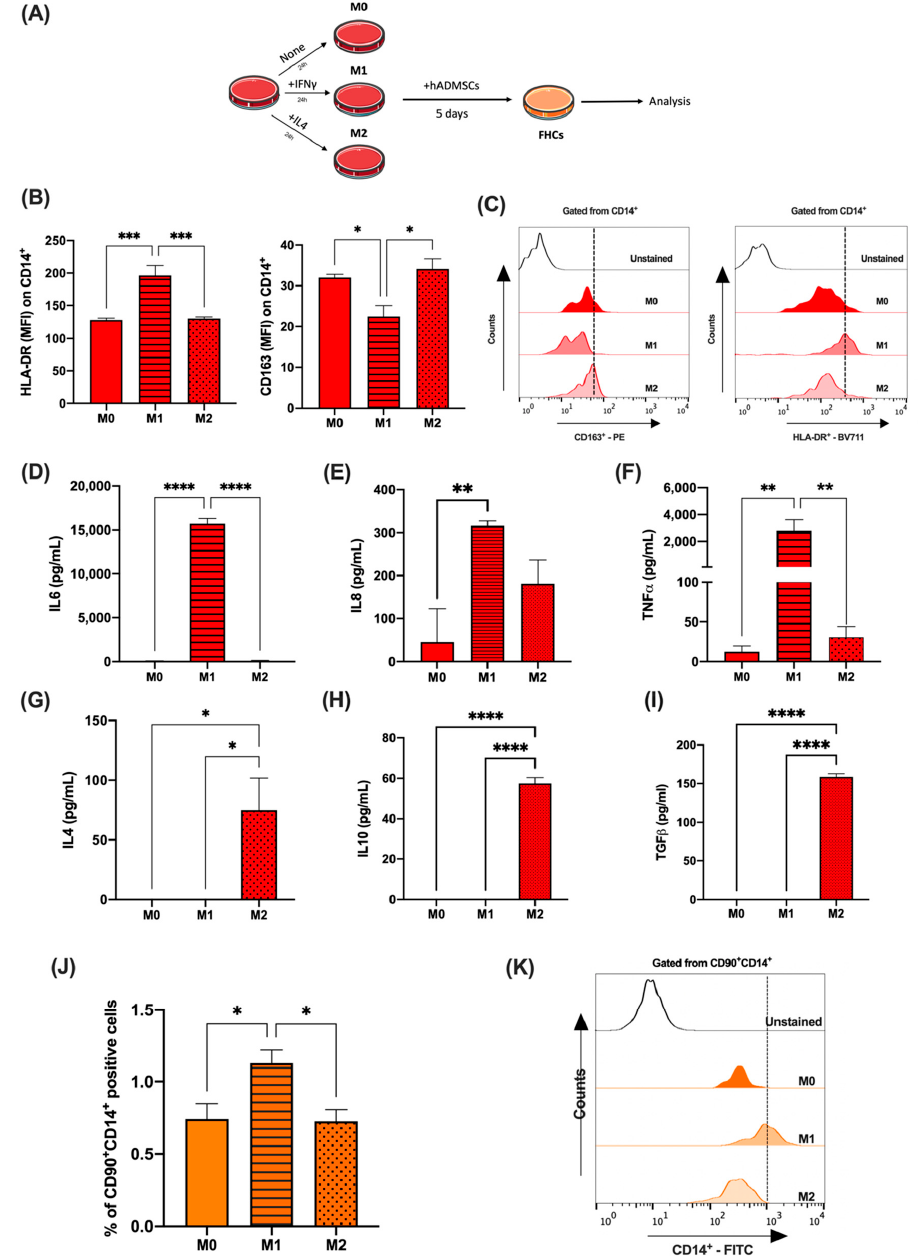
Figure 2. Human monocyte polarisation to M1 yields a greater number of FHCs. ( A ), Schematic representation of experimental monocyte polarisation and co-culture conditions. ( B ), Mean fluorescence intensity (MFI) of surface markers CD163 and HLA-DR on control, M1 (dashed bar) and M2 (dotted bar) polarised monocytes (n = 4). ( C ), Representative FACS histograms of CD163 and HLA-DR fluorescence intensity gated from CD14 + Unstained (clear) M0 (dark red) M1 (red) and M2 (light red) human monocytes are shown. Cytokine levels of ( D ), IL6; ( E ), IL8; ( F ), TNF α ; ( G ), IL4; ( H ), IL10 and ( I ), TGF β in cell supernatants from control, M1 (dashed bar) and M2 (dotted bar) polarised monocytes (n = 4). ( J ), Percentages of CD90 + CD14 + cells of hADMSCs cocultures with M0, M1 (dashed bar) and M2 (dotted bar) polarised monocytes (n = 4). ( K ), Representative FACS histograms of CD14 expression in gated CD90 + C14 + cells from hADMSCs cocultures with M0, M1 and M2 monocytes. *, p < 0.05; **, p < 0.01; ***, p < 0.001; ****, p < 0.0001 in one-way ANOVA with Tukey’s multiple comparison post-hoc